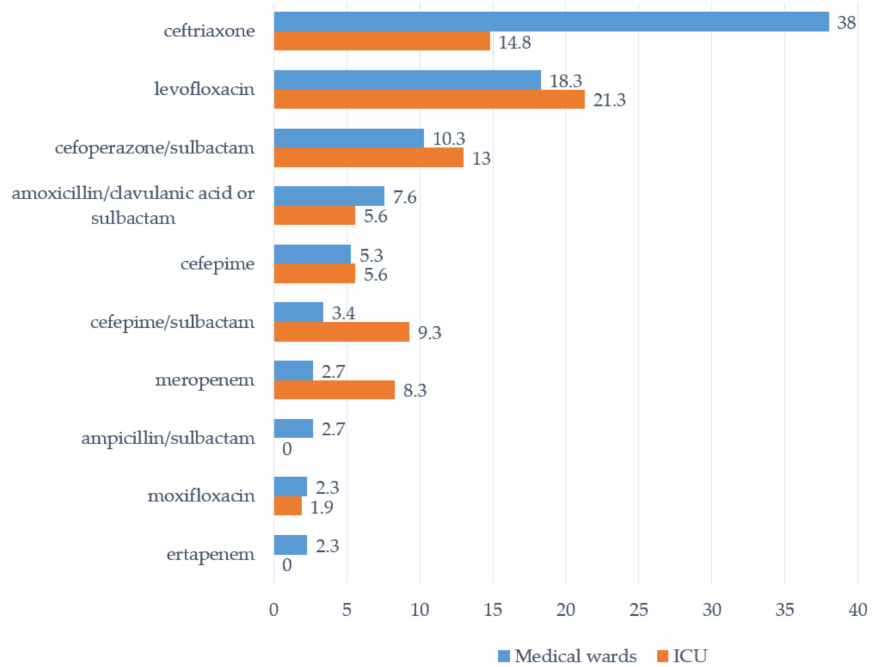
Figure 1. Top 10 systemic antibiotics administered to patients with “COVID-19/pneumonia” in COVID-19 medical wards and ICUs of 6 Russian hospitals, % of